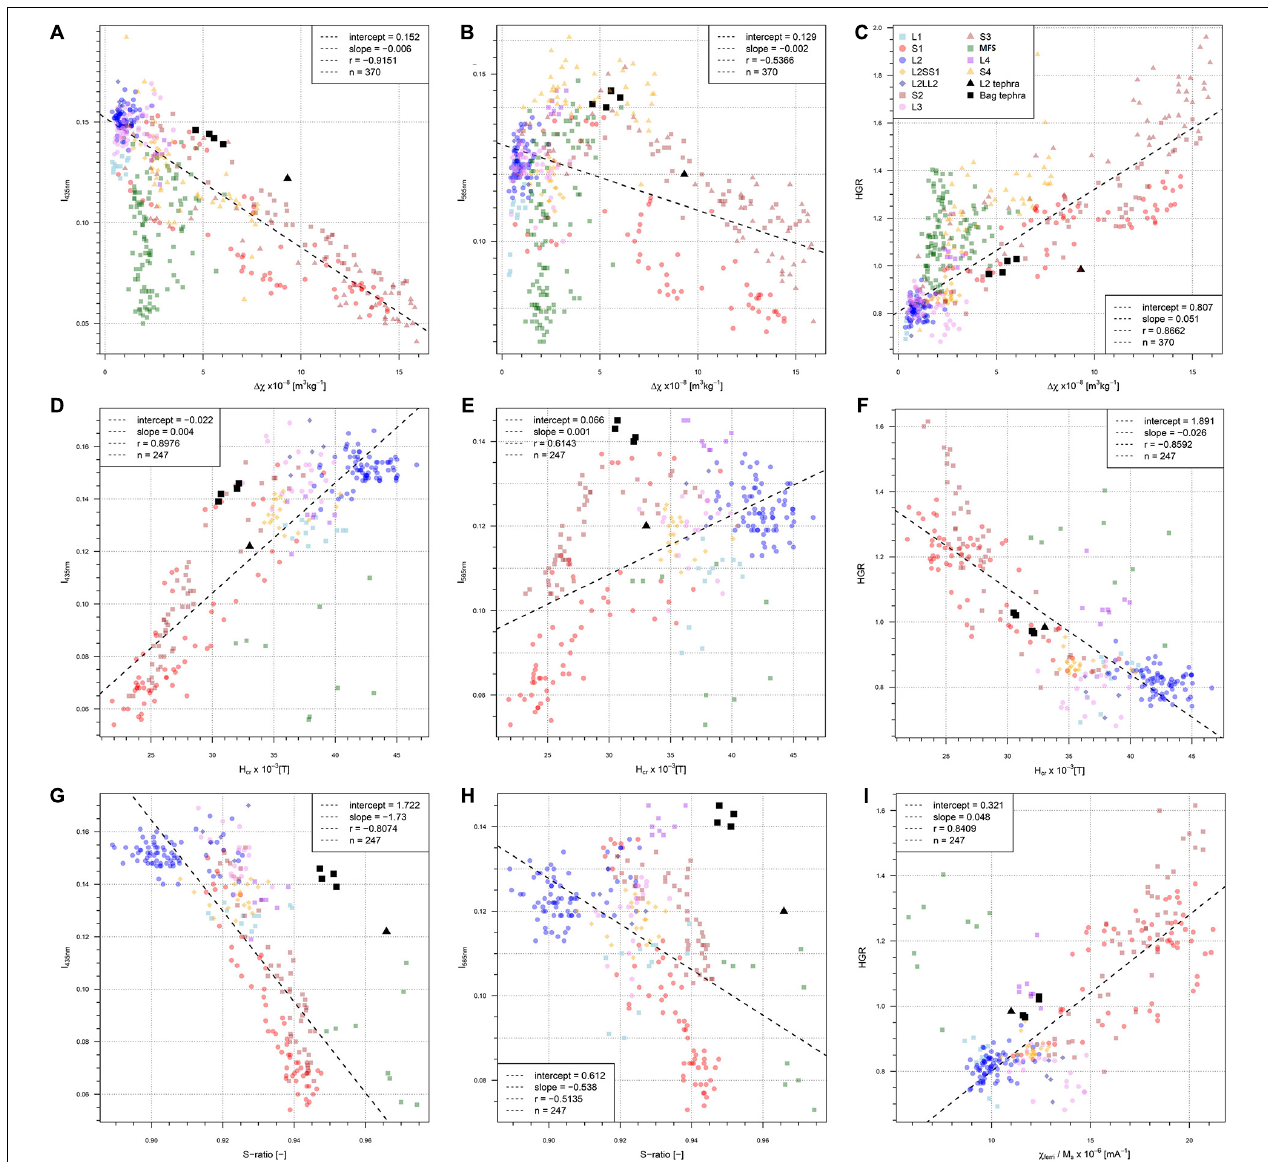
FIGURE 8 | Scatterplots of integrated magnetic and colorimetric data from the Zemun LPS. Note, that samples stemming from the MFS (marshy floodplain sediments) and the tephra layers are excluded for calculated regression fit and correlation coefficient, resulting in 370 samples out of a total of 479 for (A–C) and 247 samples out of a total of 262 for (D–I)